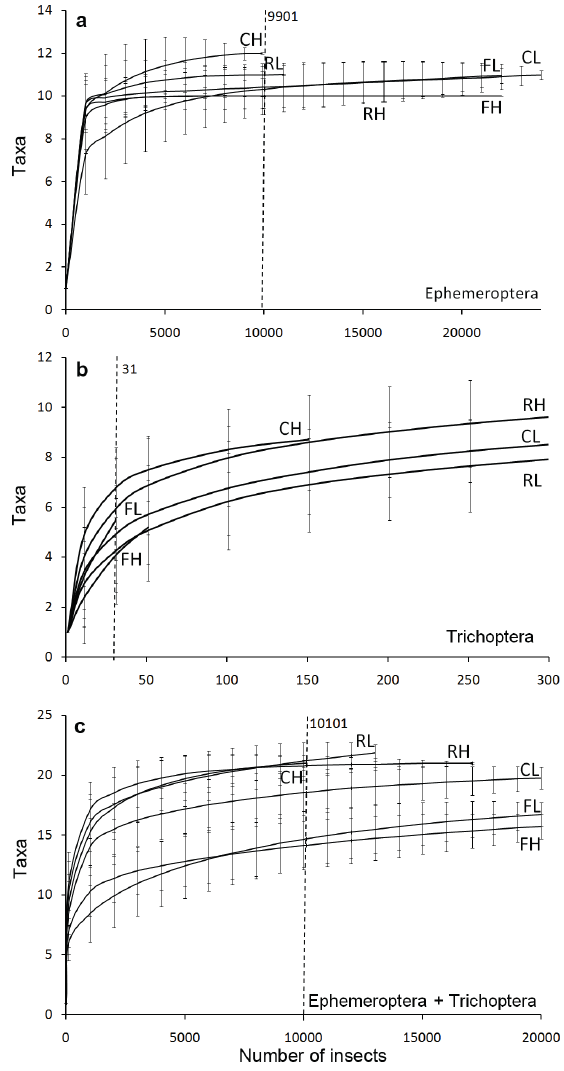
Figure 4 - Rarefaction curves based on the number of individuals of: a ) ephemeroptera assemblage, b ) Trichoptera assemblage and c ) ephemeroptera +Trichoptera assemblage in different habitats (R: riffles, C: coarse substrate runs, F: fine substrate runs) during two hydrological periods (H: high water period, l: low water period). The minimum number of individuals is indicated with a dashed line. Confidence intervals are shown and they are specified in Table